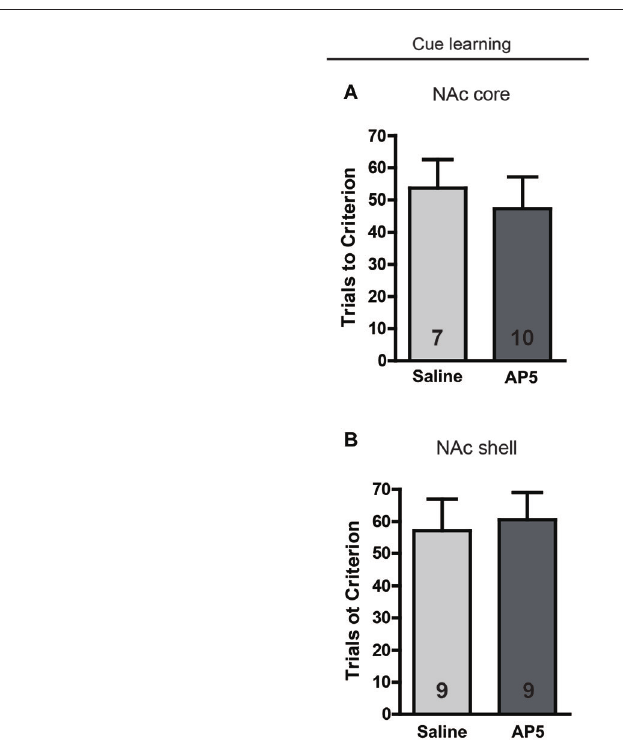
FIGURE 3 | No effect of AP5 infused into the NAc core or shell on initial visual-cue learning (A, NAc core; B, NAc shell) or spatial discrimination (C, NAc core; D, NAc shell) . In this experiment, only association learning tasks were conducted. The rats were required to learn an association